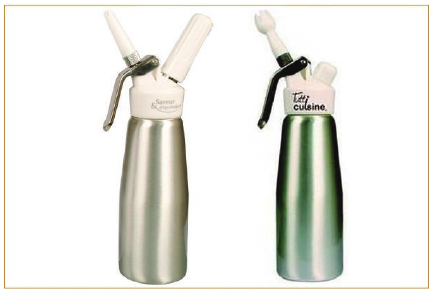
Figure 1: Whipped cream siphon implicated.